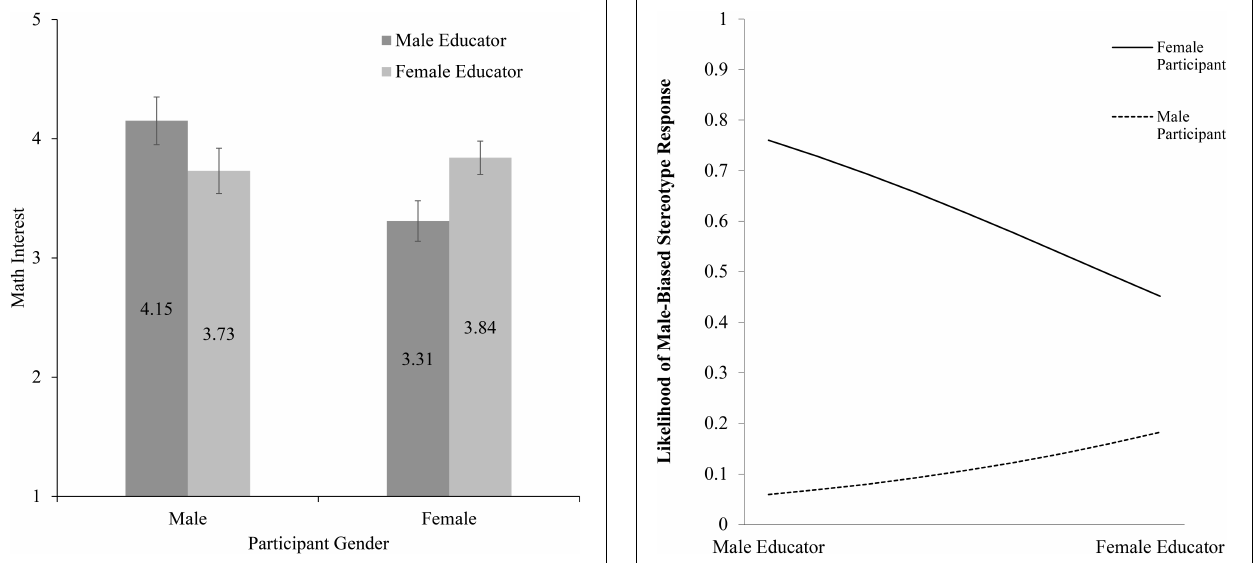
FIGURE 1 | Math interest as a function of participant gender and educator gender (w. standard error bars).